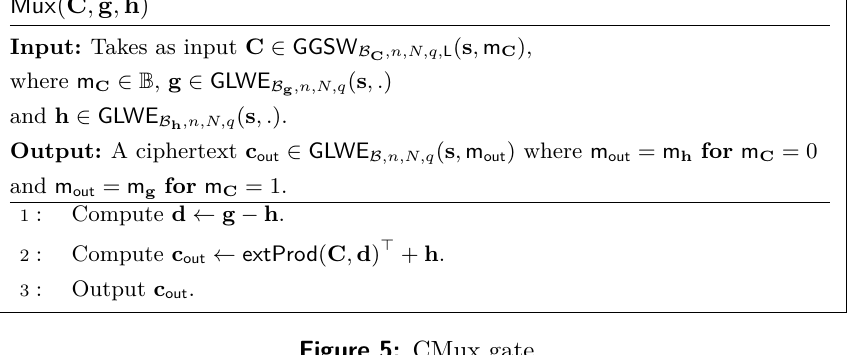
Figure 5: CMux gate.